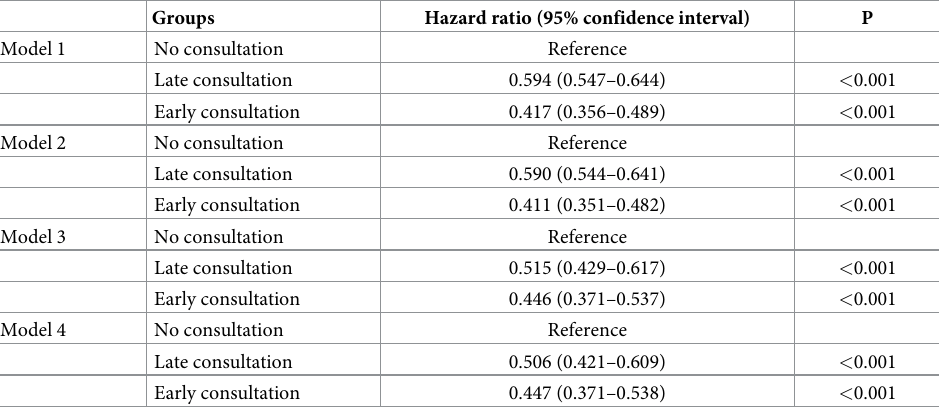
Table 4. Relationship between all-cause mortality and consultation time.